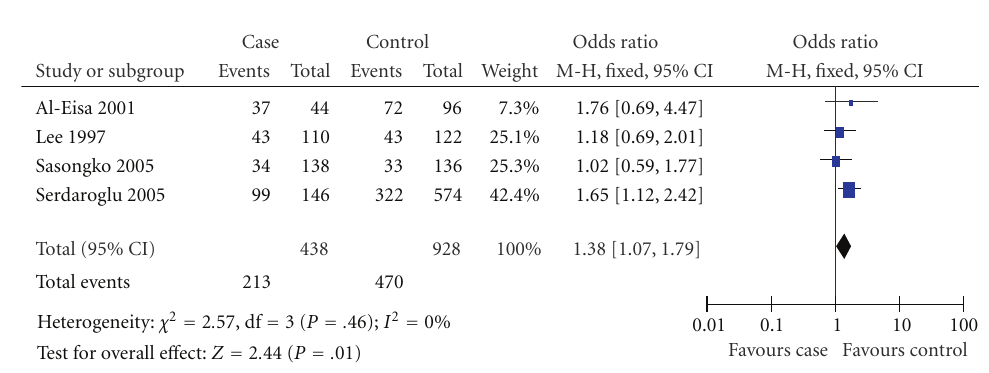
Figure 1: Relationship between D allele and MCNS risk in Asians.